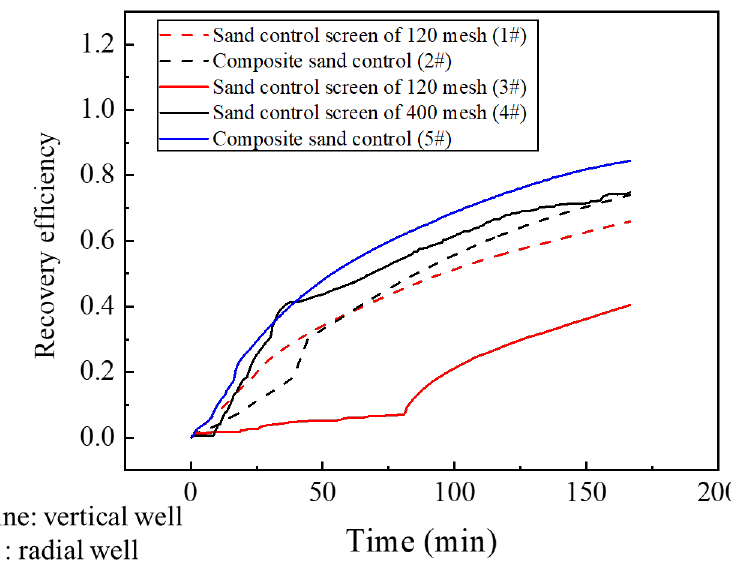
Figure 14. Comparison of recovery efficiency of different sand control methods in vertical wells and radial wells.